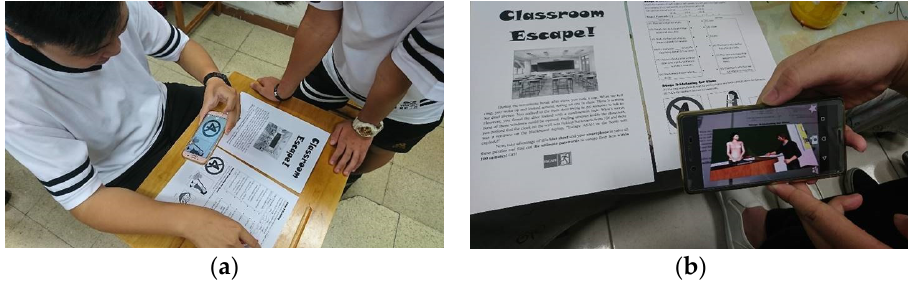
Figure 1. English-learning scenario supported by the HP Reveal app [48]: ( a ) Students use the AR app to align images in textbook content; and ( b ) the HP Reveal app displays teaching videos for specified learning topics, based on images in the textbook.